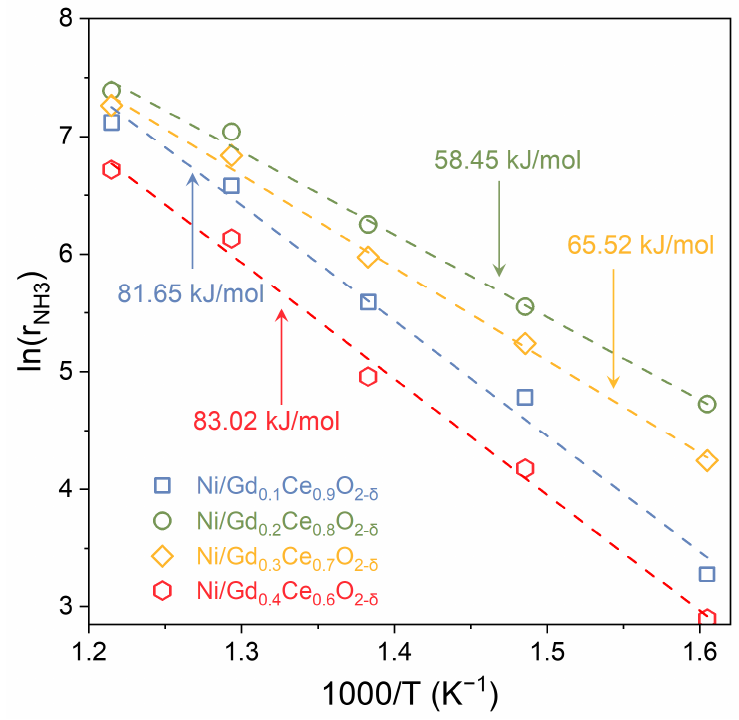
Figure 5. The Arrhenius plots of ammonia decomposition over Ni/Gd x Ce 1-x O 2- δ